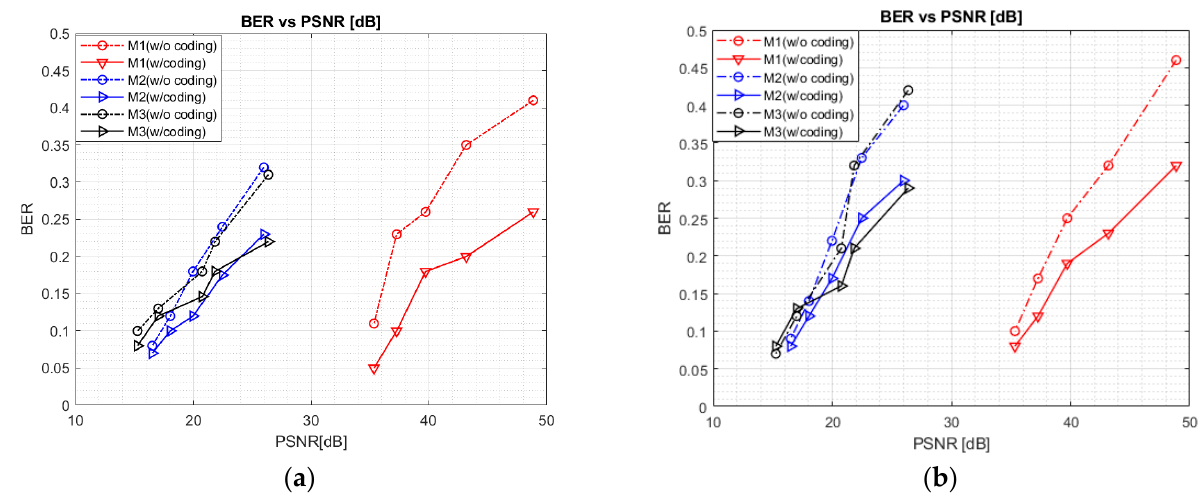
Figure 8. BER performance with respect to PSNR [dB] for images captured via an optical wireless channel. ( a ) m = 250 and ( b ) m = 500.